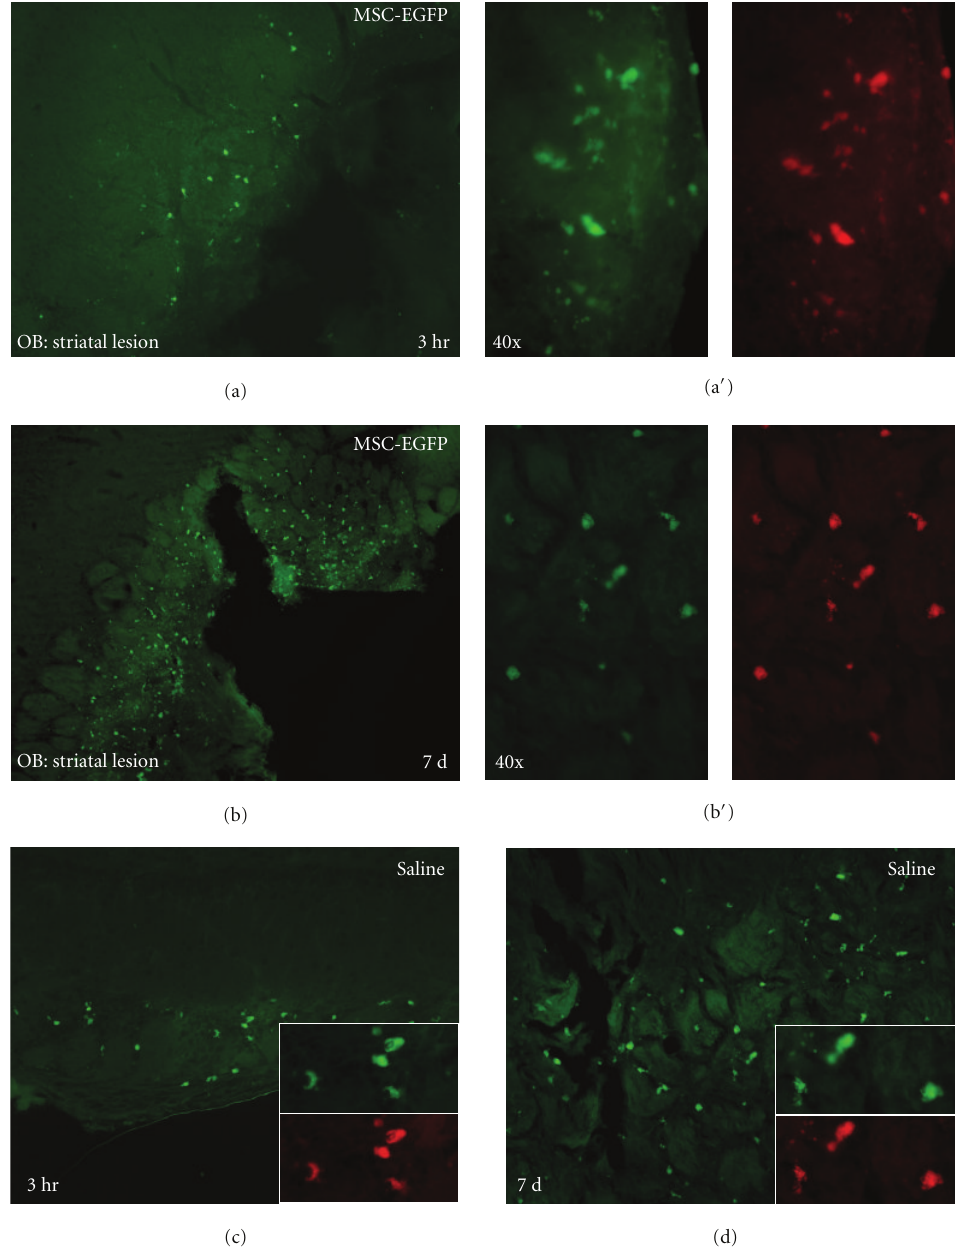
Figure 2: Autofluorescence in the olfactory bulb (OB) after intranasal delivery of MSC-EGFPs to mice with prior mechanical lesions in striatum. Fluorescent structures are observed within the glomerular layer of the OB at 3 hours and 7 days after intranasal administration of MSC-EGFPs (a), (b) or saline (c), (d). Higher magnification images of the OB at 3 hours ((a (cid:3) , c) inset) and 7 days ((b (cid:3) , d) inset) imaged with both the GFP and Texas Red bandpass filters show a one-to-one correlation between the number and intensity of stained